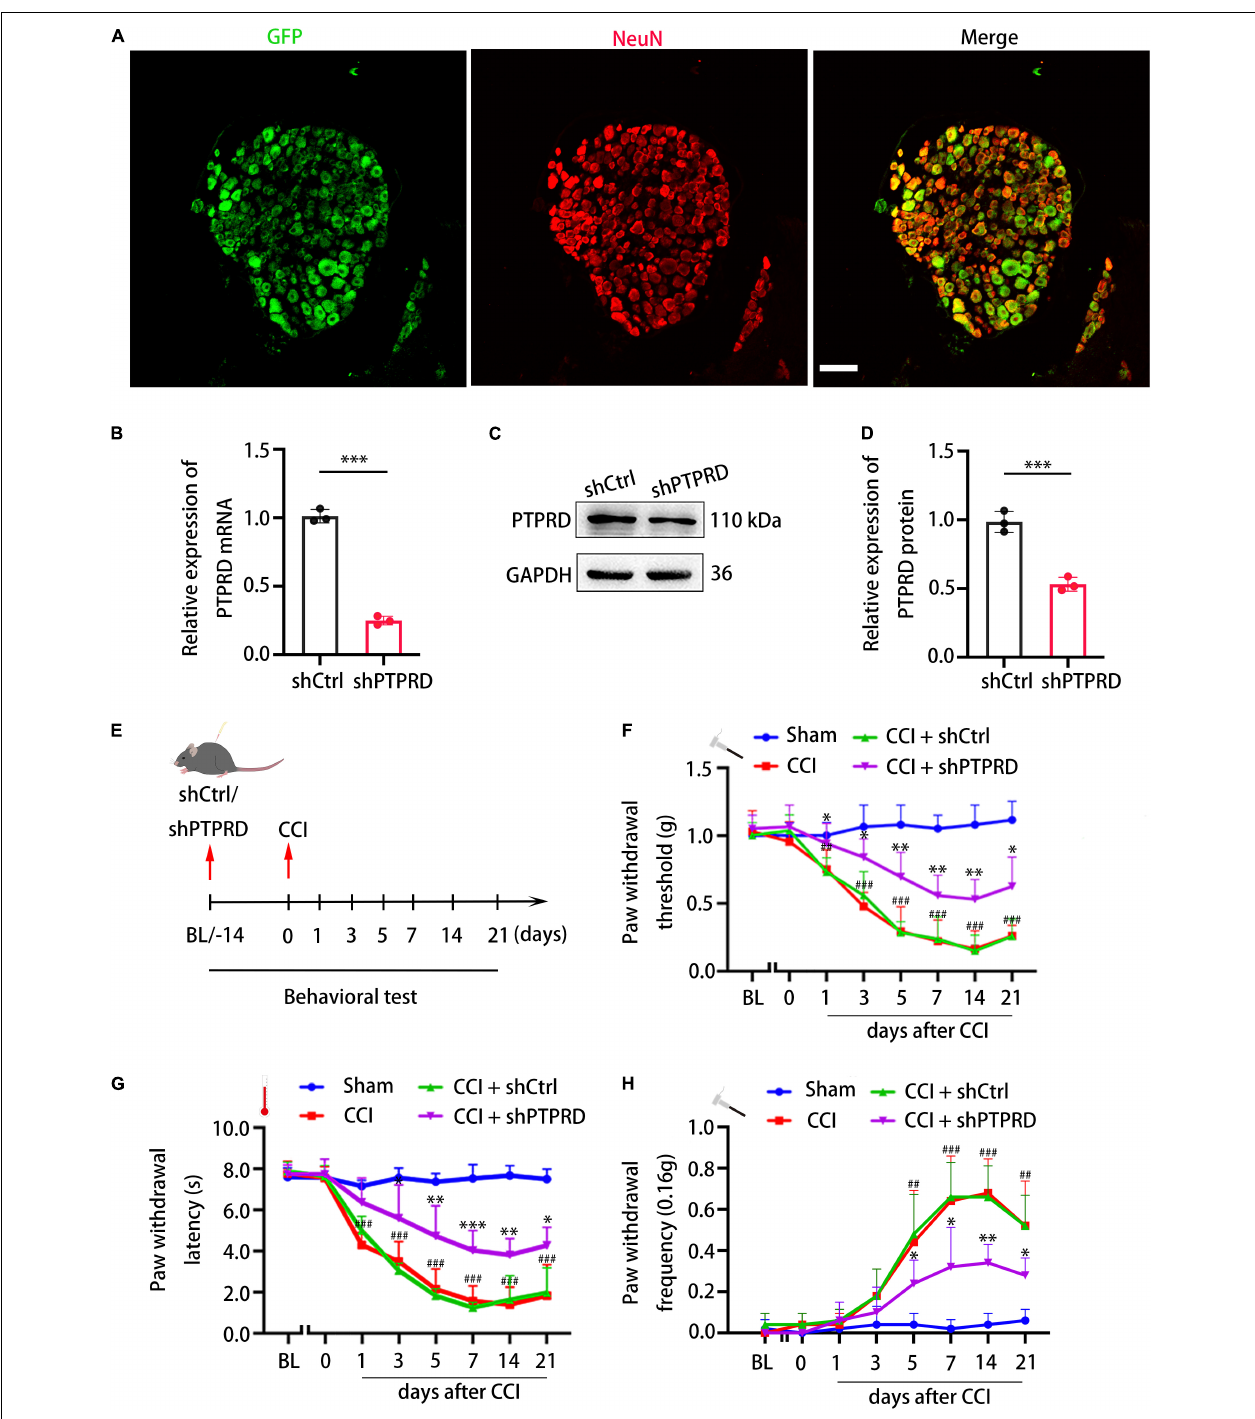
FIGURE 3 | Protein tyrosine phosphatase receptor type D knockdown attenuates neuropathic pain following CCI. (A) Representative images of GFP (green) and NeuN staining (red) 14 days after shPTPRD injection in the DRG. Scale bar, 100 µ m. (B) qRT-PCR analysis of the relative expression of PTPRD in DRGs transfected with shCtrl or shPTPRD after CCI. N = 3, ∗∗∗ p < 0.001. (C) Western blot of PTPRD in DRG tissues transfected with shCtrl or shPTPRD after CCI. Each experiment was repeated three times. (D) Quantitative analysis of data in (C) . GAPDH served as the loading control. N = 3, ∗∗∗ p < 0.001. (E) Schedule of lentivirus administration, surgery, and behavioral testing. (F–H) Paw withdrawal threshold, paw withdrawal latency, and paw withdrawal frequency prior to virus injection (BL), on the day of surgery, or 1, 3, 5, 7, 14, and 21 days after CCI. N = 6 mice per group. CCI + shPTPRD vs. CCI + shCtrl, ∗ p < 0.05, ∗∗ p < 0.01, ∗∗∗ p < 0.001. CCI vs. sham, # p < 0.05, ## p < 0.01, ### p < 0.001. Statistical comparisons were performed using unpaired Student’s t -test (B,D) or two-way ANOVA with Tukey’s post hoc test (F–H) .